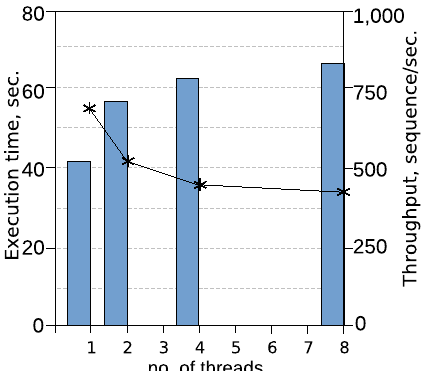
Figure 12. The execution time and throughput of generating 30000 sequences.